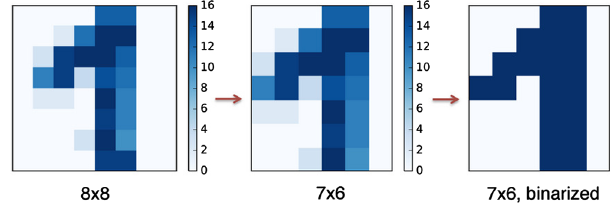
FIG. 3. OptDigits preprocessing steps. The original 8 × 8 pictu- res are cropped to 7 × 6 arrays by removing columns from the left and the right, as well as by deleting a row from the bottom. Fina- lly, the four-bit gray scale is thresholded at the midpoint and bina- rized to f − 1 ; þ 1 g . Figure 4(a) shows some pictures from the test set.